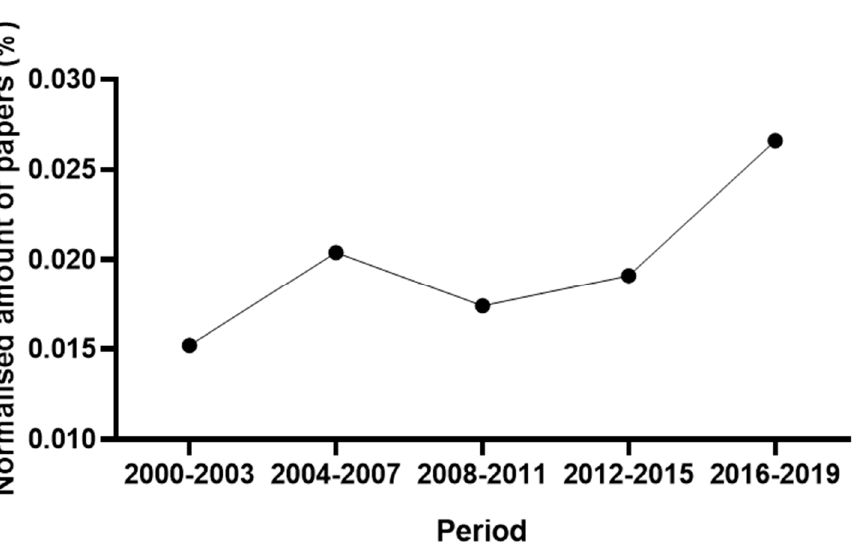
Figure 1. Papers: course of publications over the observed period. The number of papers was normalised on the total amount of documents in subject area “Agricultural and Biological Sciences”.